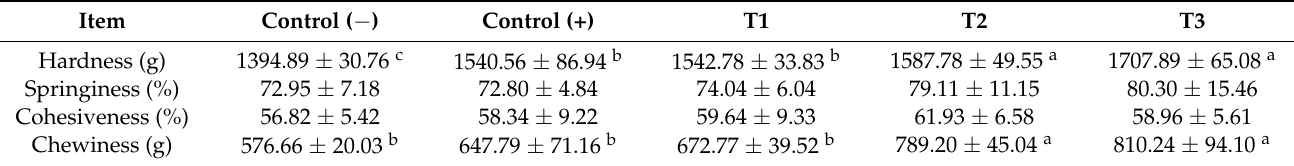
Table 4. Textural properties of pork patties with fermented soy